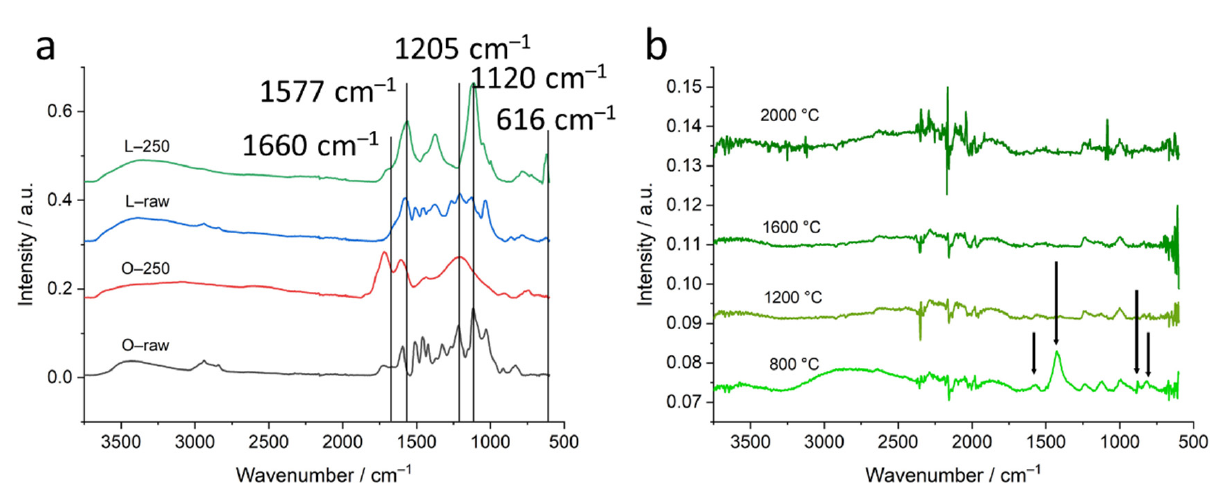
Figure 10. FTIR curves measured for lignosulfonate and organosolv samples heat-treated at different temperatures. Panel ( a ) displays curves of samples L raw and L 250 together with curves of samples O raw and O 250 . Panel ( b ) displays curves of lignosulfonate samples heat-treated at higher temperatures. Lines and arrows indicate peaks discussed in the text.